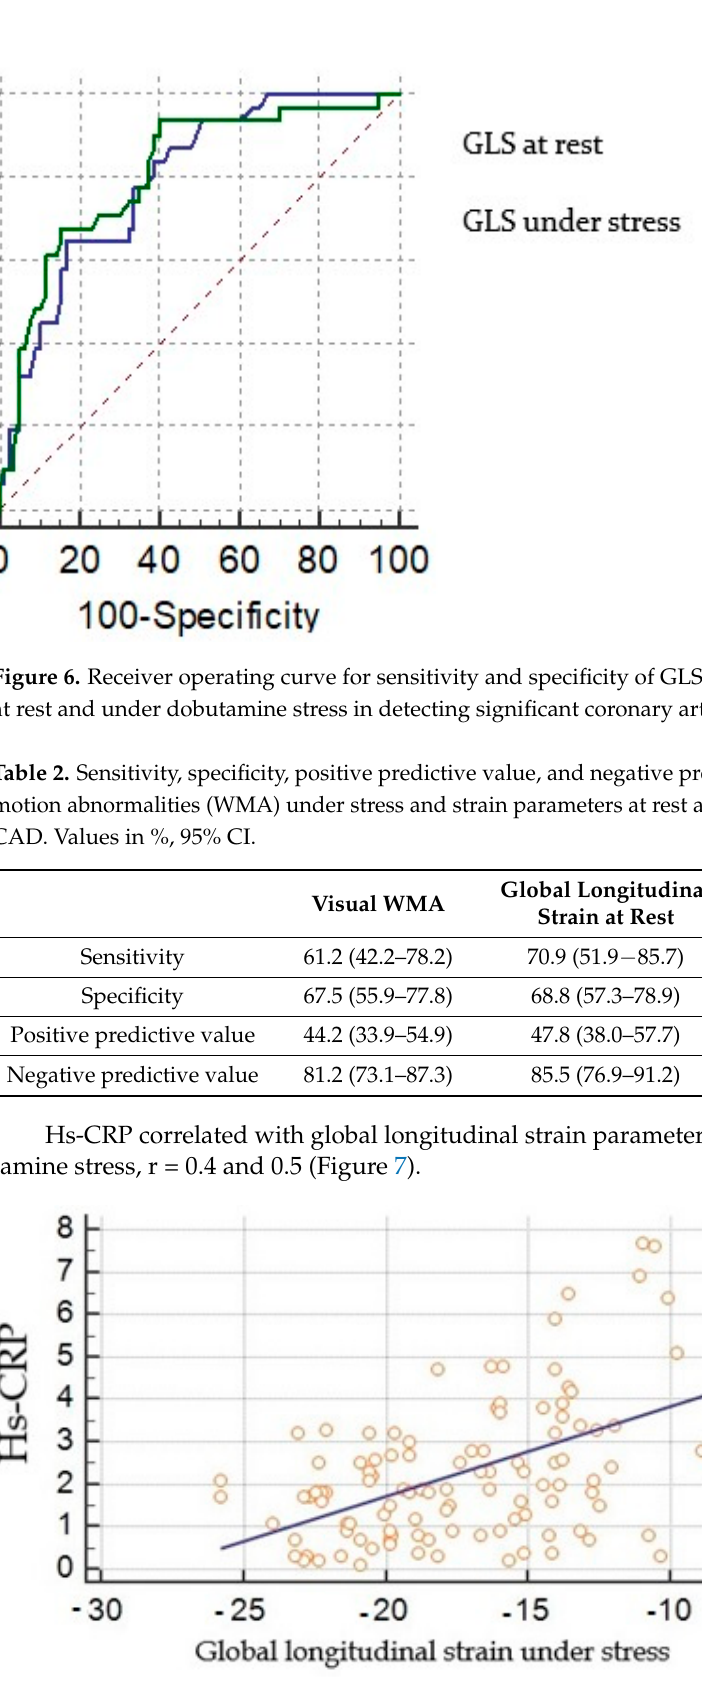
Figure 5. Mean values of global longitudinal strain at rest and under stress in relation to the num- ber of involved coronary vessels.